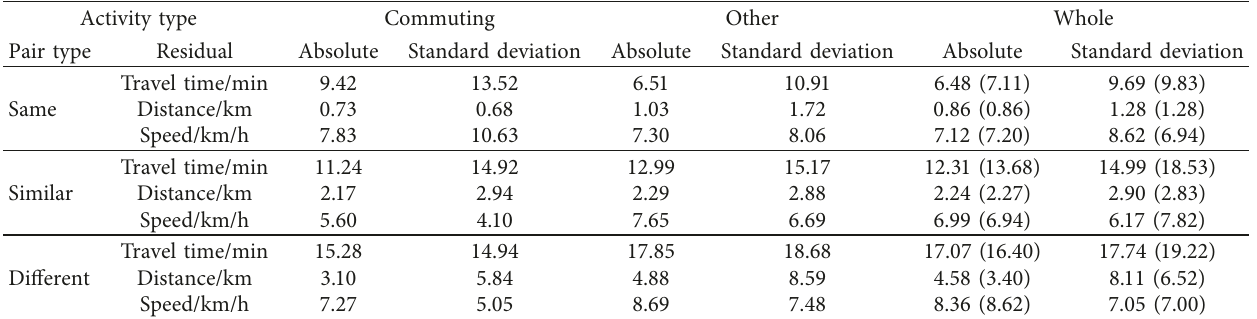
Table 7: Absolute residual values and standard deviations of trip indicators for the path